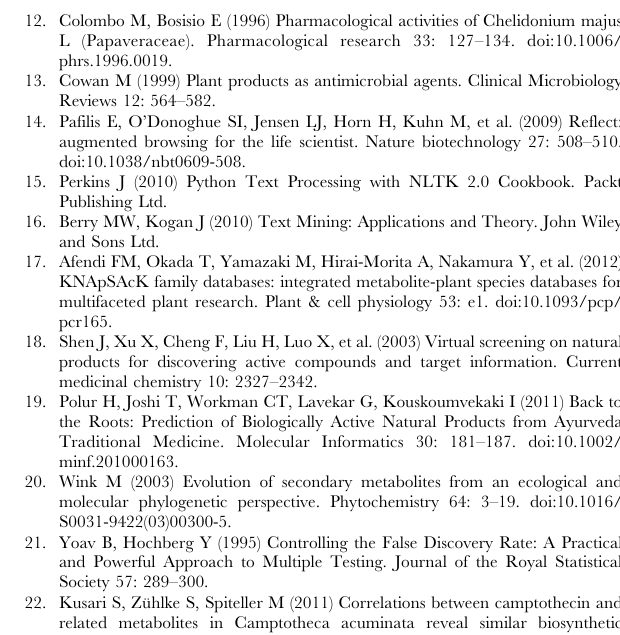
Figure S1 Mapping the phytochemical space on the plant taxonomy. 37,351 phytochemicals were mapped on the plant taxonomy. Only 8% of the recorded phytochemicals show localized enrichment ( p -value , 10 2 4 ). The taxonomy of land-plant species (embryophyta) was retrieved from NCBI taxonomy (http://www.ncbi.nlm.nih.gov/taxonomy). Nodes represent Class- es (yellow), Orders (blue), Families (green) and Genera (pink) of the taxonomy tree. Links are placed between a parent and a child node, if they share conserved phytochemicals. A phytochemical is conserved, when it is overrepresented on both the parent and the child nodes. The width of the link corresponds to the number of conserved phytochemicals between parent and child nodes. The size of the node corresponds to the number of overrepresented phytochemicals on a given class, order, family or genus. Table S1 List of phytochemicals described as SMILES that are localized on a taxonomy class, order, family or